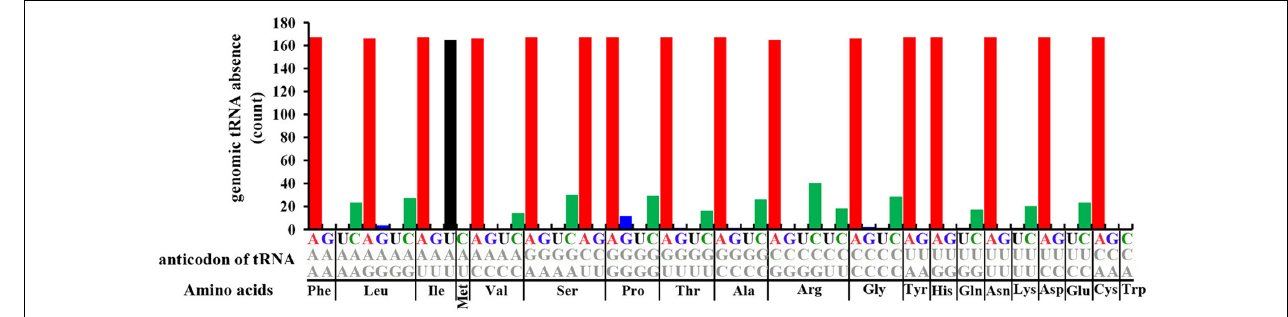
FIGURE 3 | Statistics of absences in different tRNAs in 167 archaeal genomes. The X -axis shows different amino acids and anticodons of corresponding tRNAs. The Y -axis shows statistics of tRNA loss in 167 Archaea